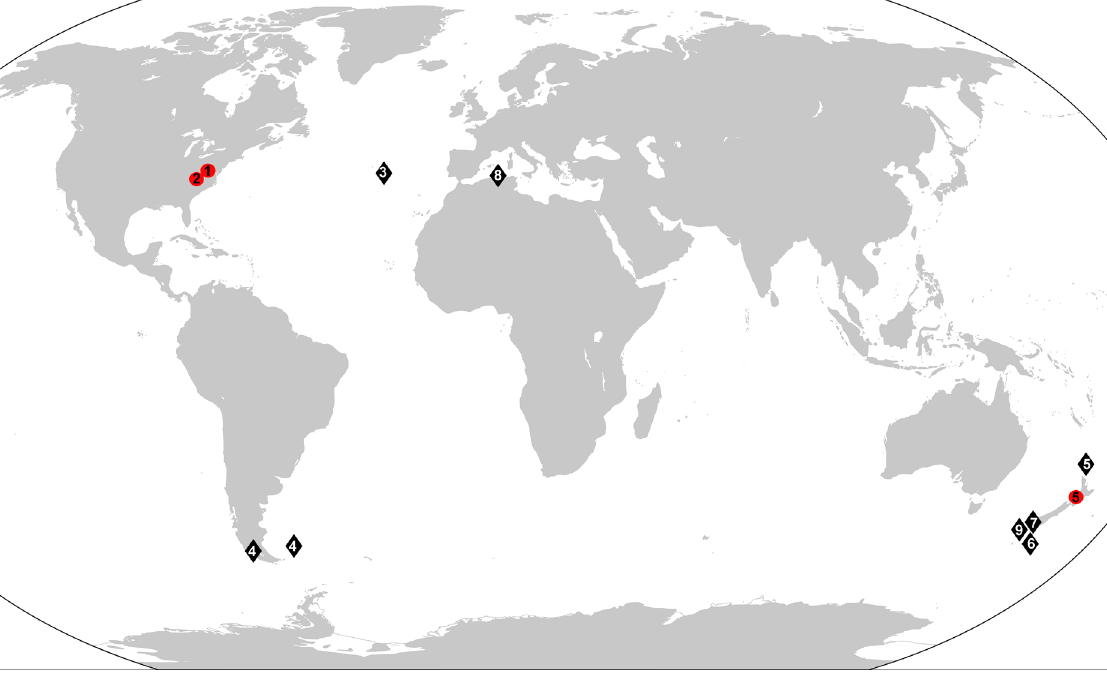
Fig. 13. Geographical distribution of the nine bifoliate species of Microporella Hincks, 1877 known to date. Red circles indicate fossil occurrences, while black lozenges indicate living records. 1 = M. bifoliata , Miocene, Maryland, USA; 2 = M. tanyae sp. nov., Pliocene, Virginia, USA; 3 = M.